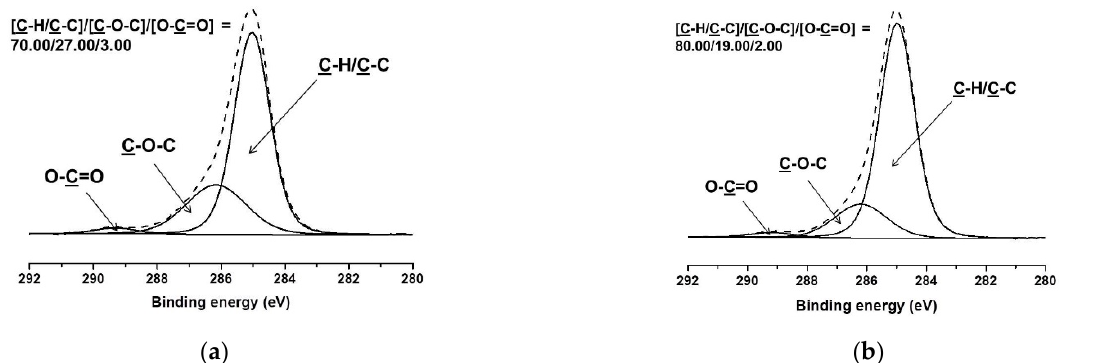
Figure 5. C1s spectra of PEO(70)/PLA(15)/BW(15) ( a ) and PEO(50)/PLA(25)/BW(25) ( b ) mats. Theoretically, for PEO(70)/PLA(15)/BW(15) fibrous material, the [C-H/C-C]/[C-O- C]/[O-C=O] ratio is 19.00/75.00/6.00. As seen from Figure 5, the experimentally estimated